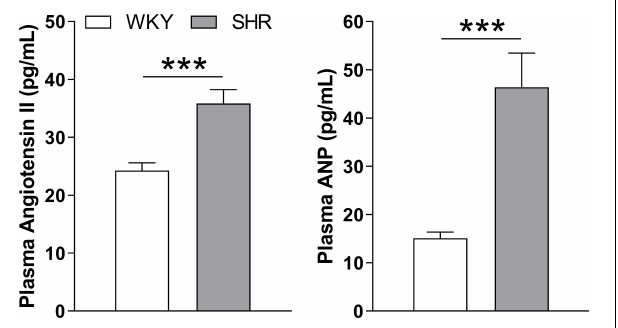
FIGURE 1 | Circulating levels of angiotensin II and atrial natriuretic hormone (ANP) I plasma from WKY and SHR rats. *** p ≤ 0.001 ( n =